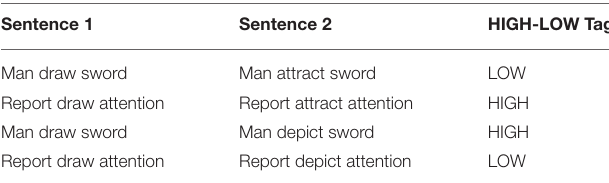
TABLE 2 | Example entries from the transitive dataset, cited from Grefenstette and Sadrzadeh [ 25].